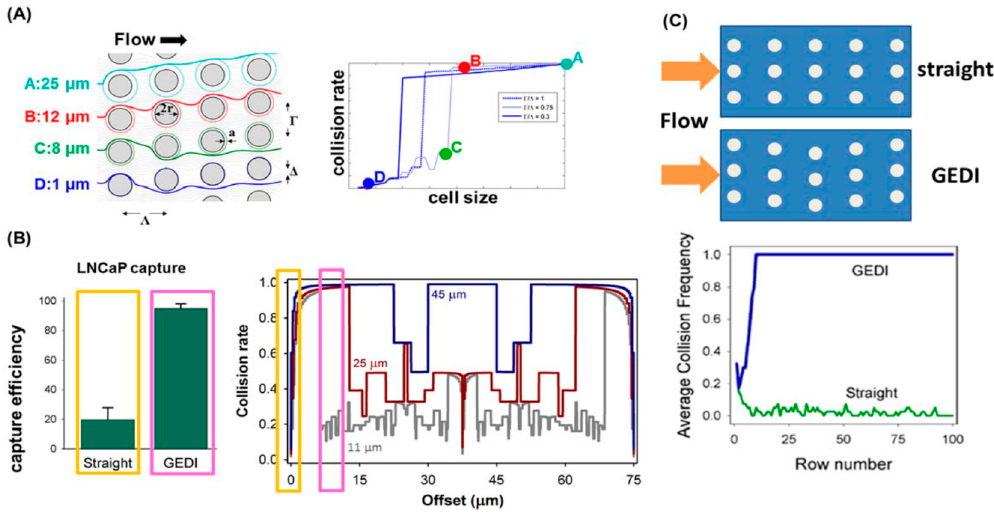
Figure 11. A typical geometrically enhanced differential immunocapture (GEDI) microfluidic device for cell capture. ( A ) Left: Top view of micropillar array. ∆ is pillar offset; Λ is pillar separation in the direction of bulk flow; Γ is the pillar separation in the direction perpendicular to bulk flow; 2 r is the pillar diameter. Light gray lines represent the fluid flow streamlines. Color lines denote trajectories of cells of various sizes. Right: The cell-wall collision rate varies with the cell size and the offset parameter of the array; GEDI prefers size-dependent collision rates introduced by a nonzero offset parameter. The solid lines are the results predicted for the flow geometry at left; four colored dots are corresponding results of four specific cell sizes. The dotted and dashed lines are results predicted for other two offset parameters; ( B ) the comparison of measured LNCaP capture efficiency on J591-functionalized devices for GEDI (7-mm offset) and straight (no offset) geometries (both geometries have the same surface-area-to-volume ratio). Right figure shows the simulated collision rates in these geometries. Straight arrays or arrays with small offsets (yellow boxes) induce low capture efficiency (left) and size independence (right). In contrast, arrays with large offsets (magenta boxes) induce high capture efficiency (left) and size dependence (right); ( C ) the collision frequency in straight (GEDI) array decreases (increases) as the sample flows through the device. Reprint from Ref. [148].